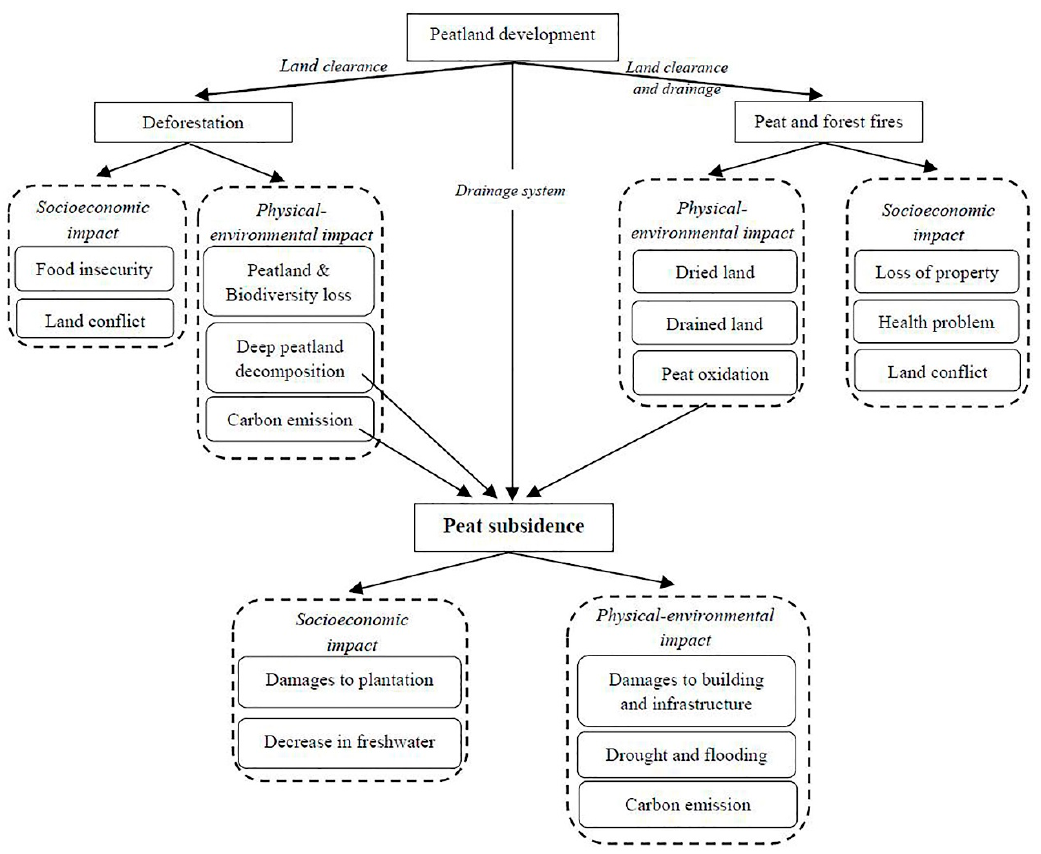
Figure 3. The relationship among peatland problems.